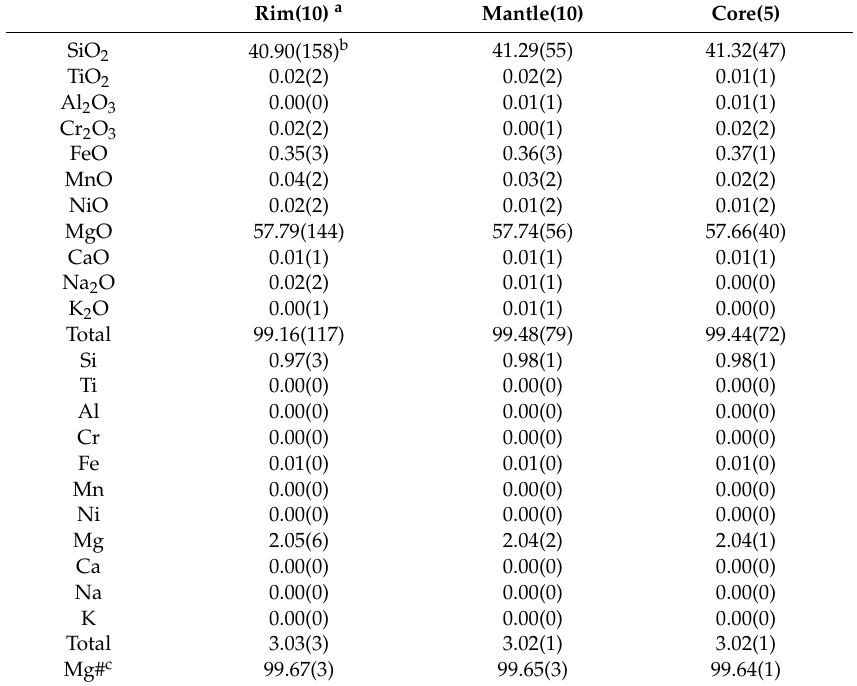
Table 1. Major element compositions (wt%) of olivines in the